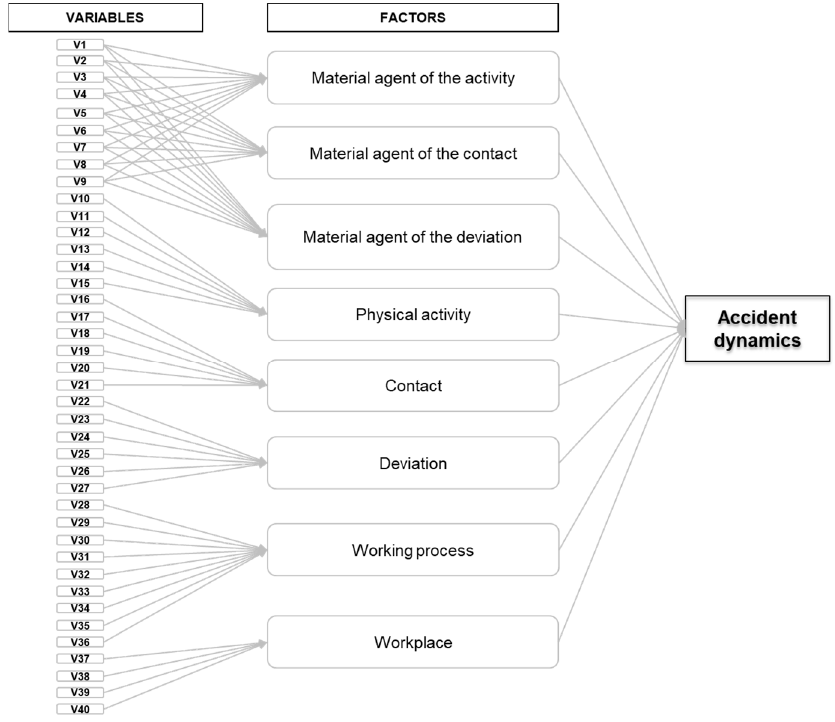
Figure 2. Relationship among accident variables and factors.